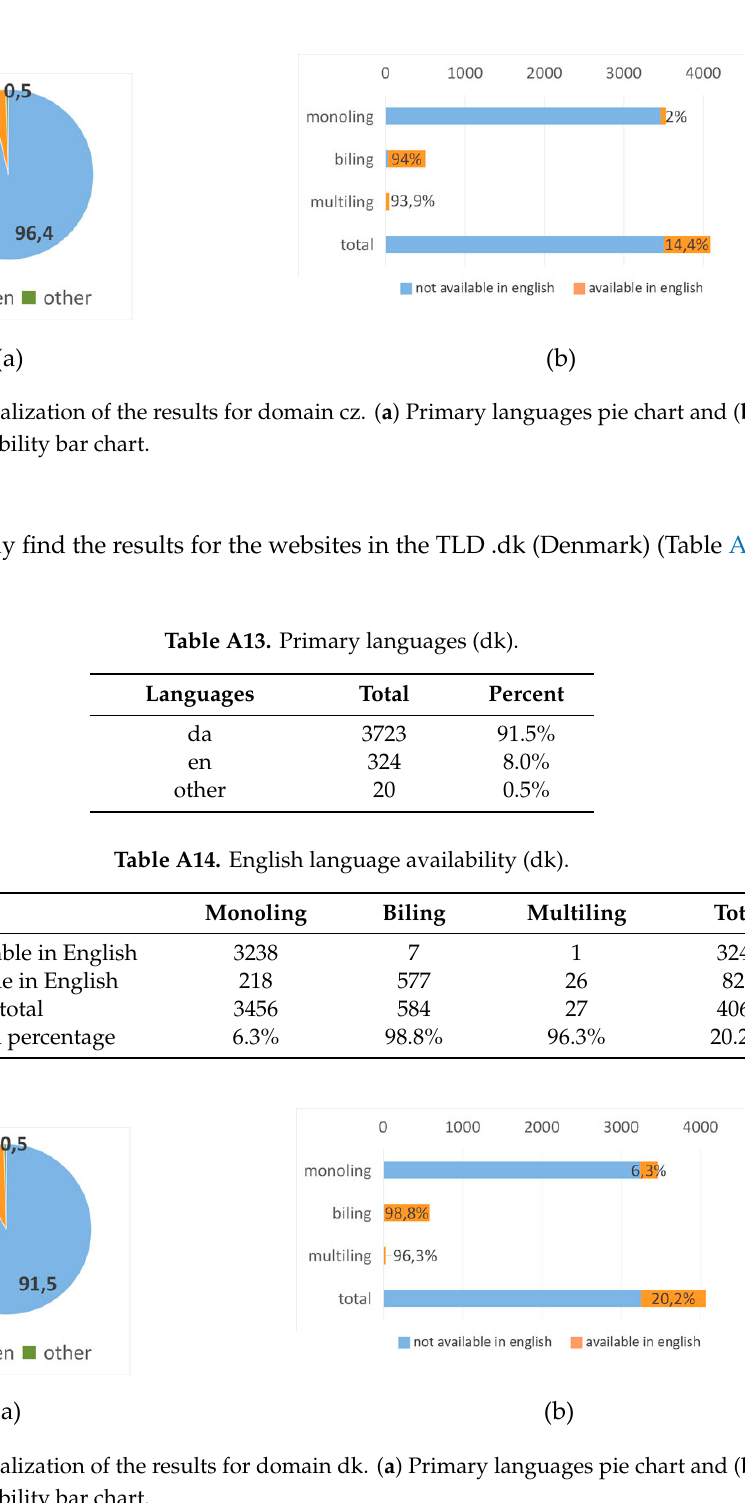
(b) Figure A5. Visualization of the results for domain cy. ( a ) Primary languages pie chart and ( b ) English language availability bar chart. B.6. Czechia Below, you may find the results for the websites in the TLD .cz (Chechia) (Table A11, Table A12, and Figure A6). Table A11. Primary languages (cz). Languages